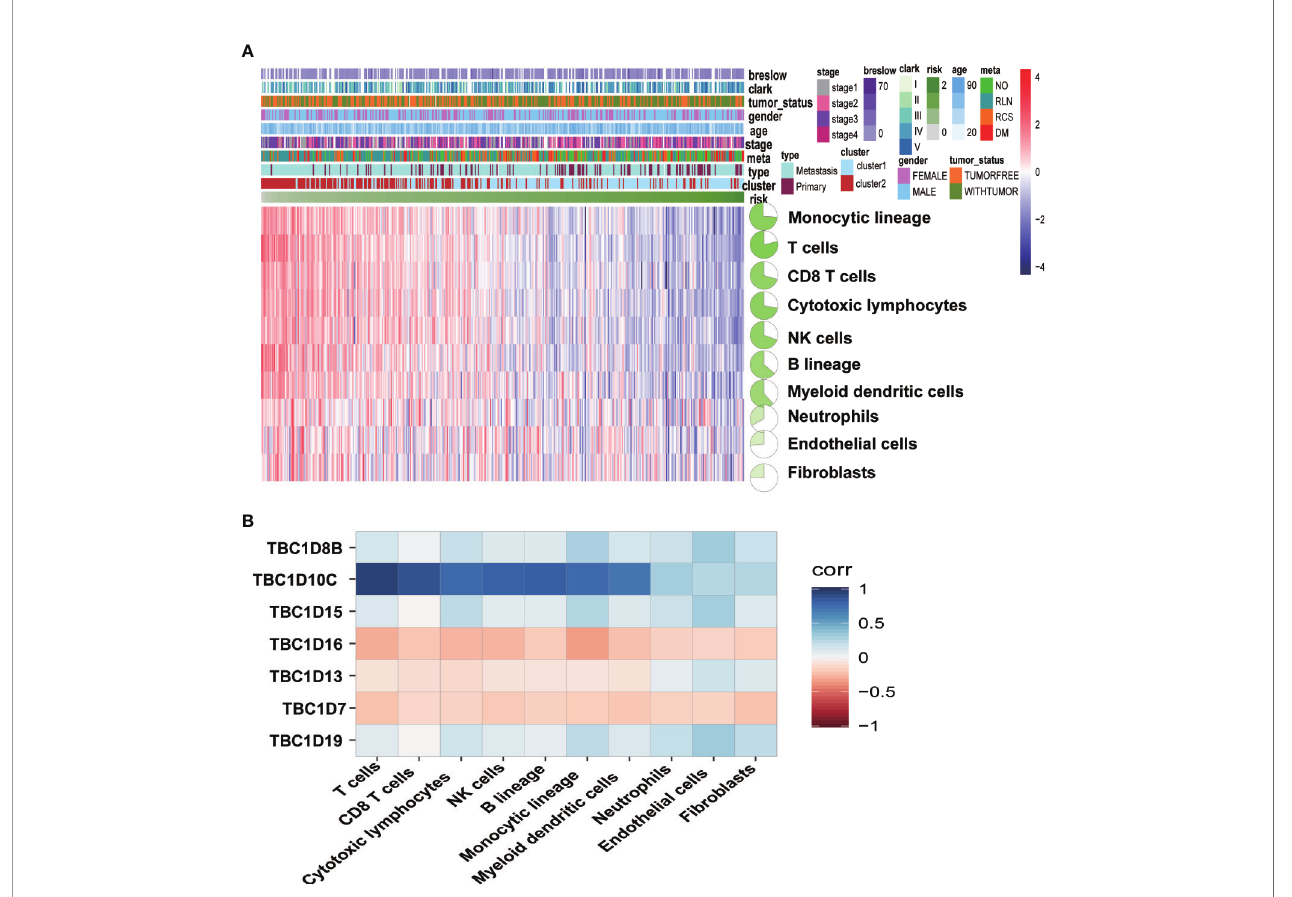
FIGURE 8 | Associations between the seven prognostic-associated TBC genes with immune characteristics. (A) The relationship of the distributions of clinical features and immune cells in TCGA is showed by heat maps. (B) Correlation analysis between the seven prognostic TBCs and immune